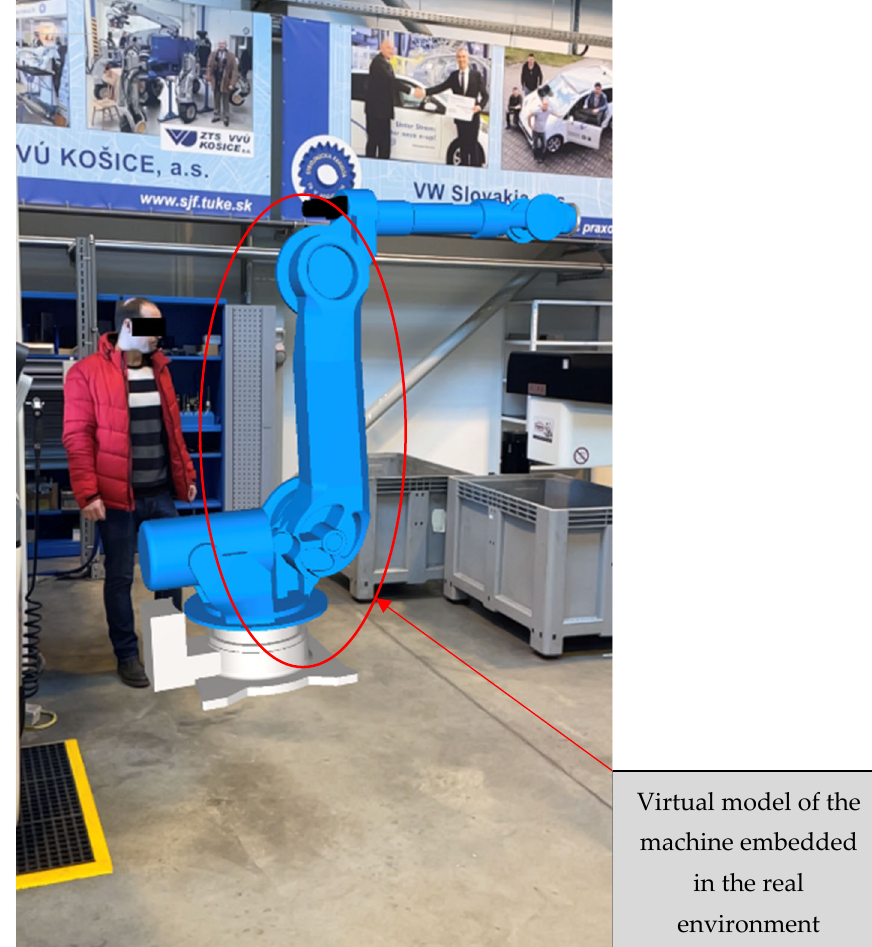
Figure 12. Display of the digital machine model in the real environment.